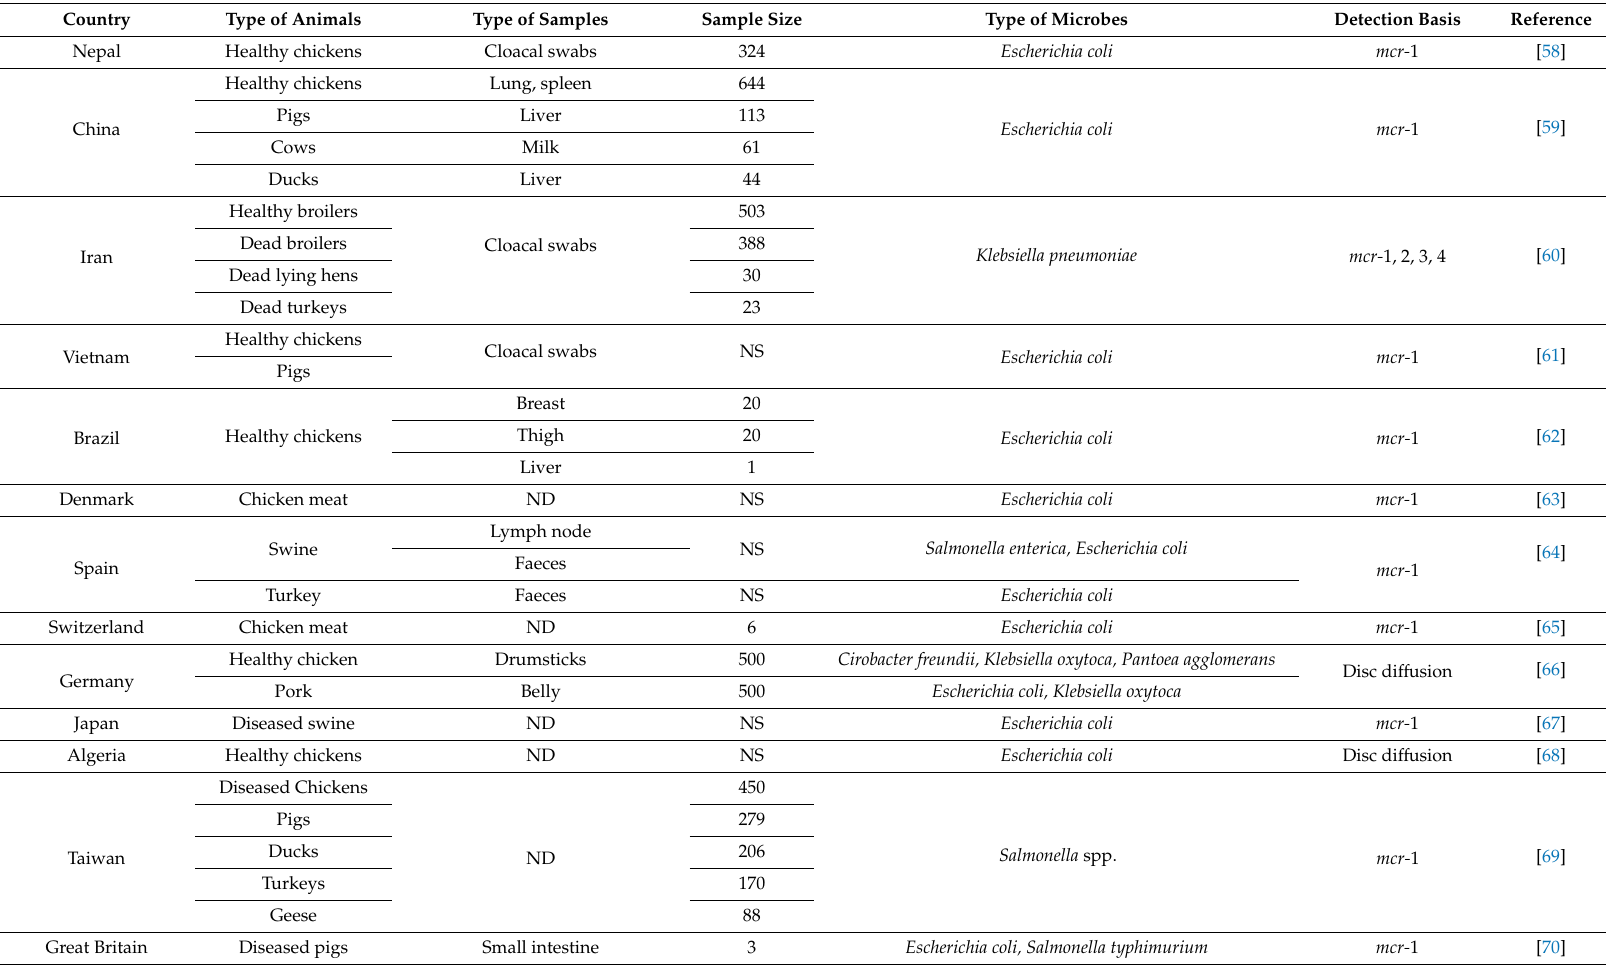
Table 2. Isolation of colistin-resistant microbes from animal-based food in di ff erent